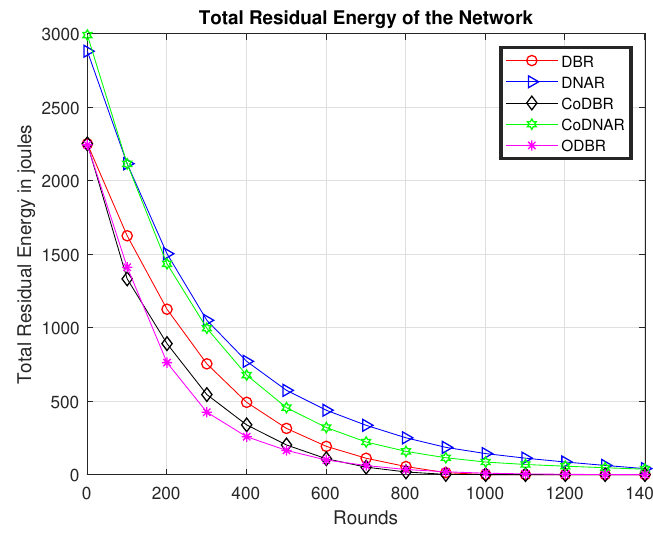
Figure 12. Total residual energy.